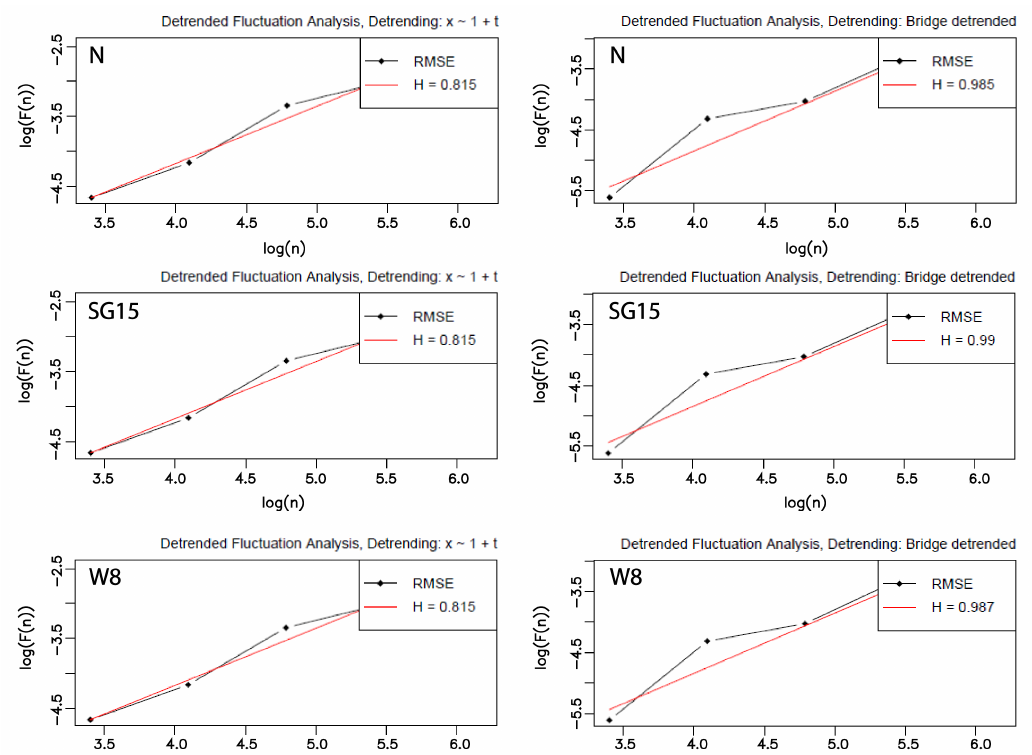
Figure 10. Example double logarithmic plots representing the fluctuation F ( n ) in the function of n (denoting the interval length) for the chosen time series. The left column shows polynomial detrending with the maximal n set to 500 and three different types of smoothing—without any (N), SG15, and W8. The right one represents the same data sets, with the same n scope and the bridge detrending method. RMSE: root mean square